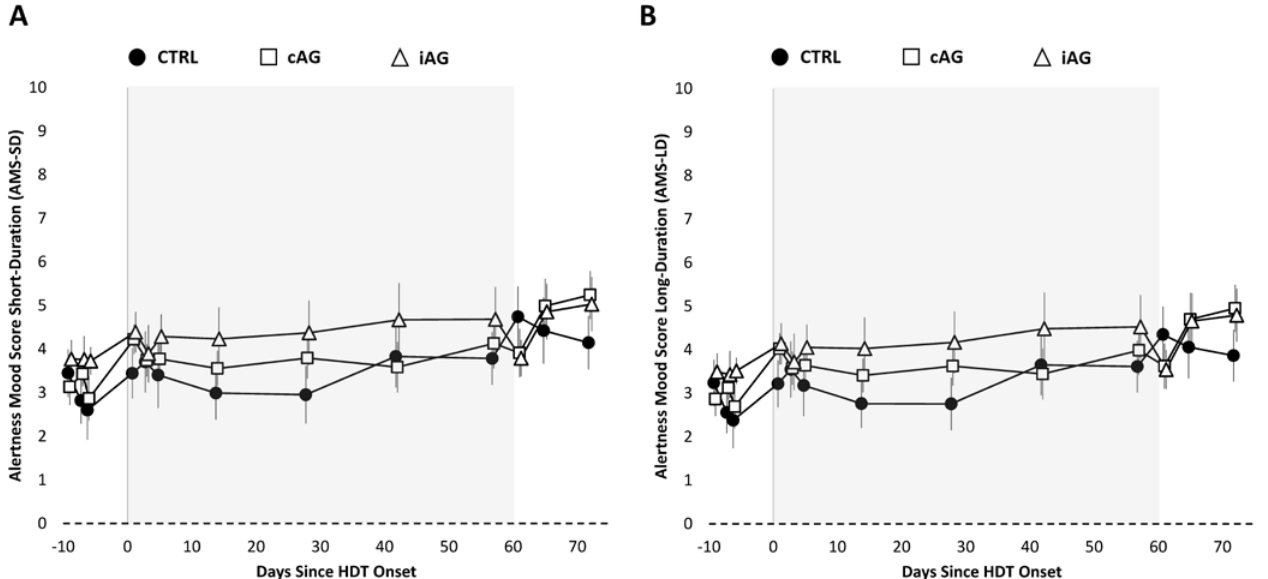
Figure 2. Alertness and Mood Survey (AMS) score for short- ( A ) and long-duration ( B ) space missions relative to the 60-day head-down tilt bed rest period (gray background) for the control group (CTRL; black circles), continuous artificial gravity group (cAG; white squares) and intermittent artificial gravity group (iAG; white triangles). Estimates reflect unadjusted means ± standard errors. Higher scores reflect higher alertness and mood disturbance.